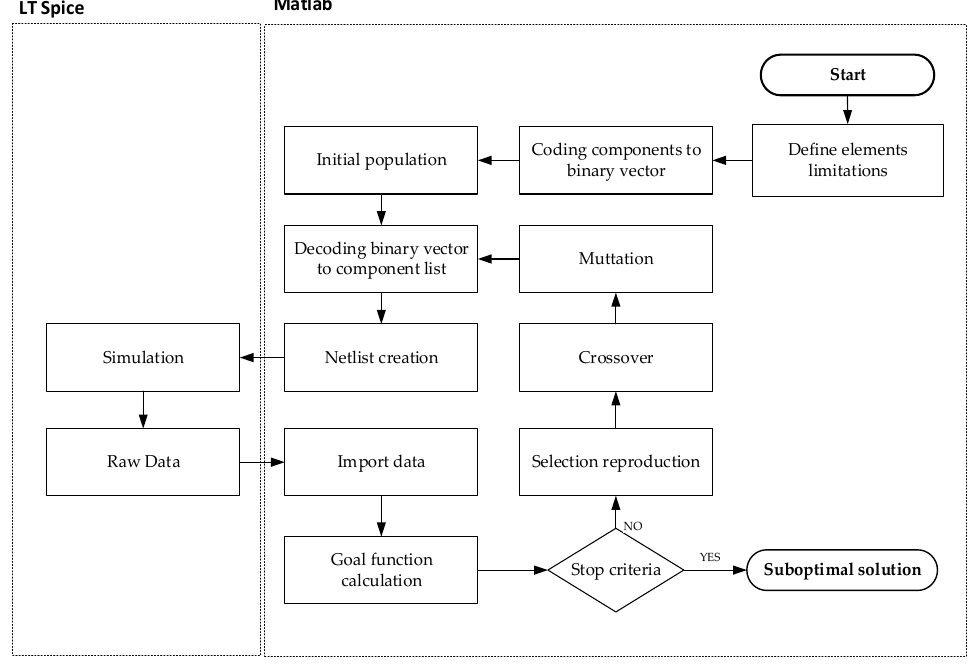
Figure 6. Implemented algorithm flow.